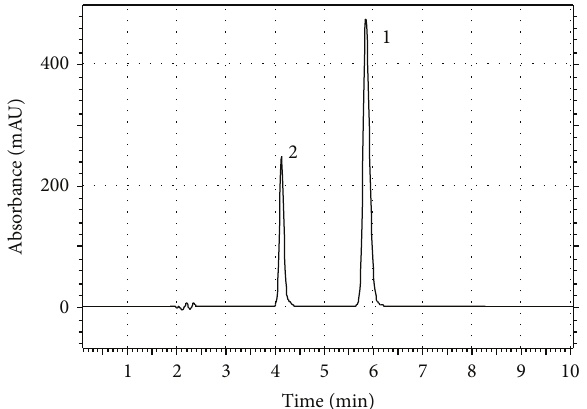
Figure 2: Typical chromatogram of diltiazem and its main impurity (desacetyl diltiazem); peak 2: desacetyl diltiazem, peak 1: